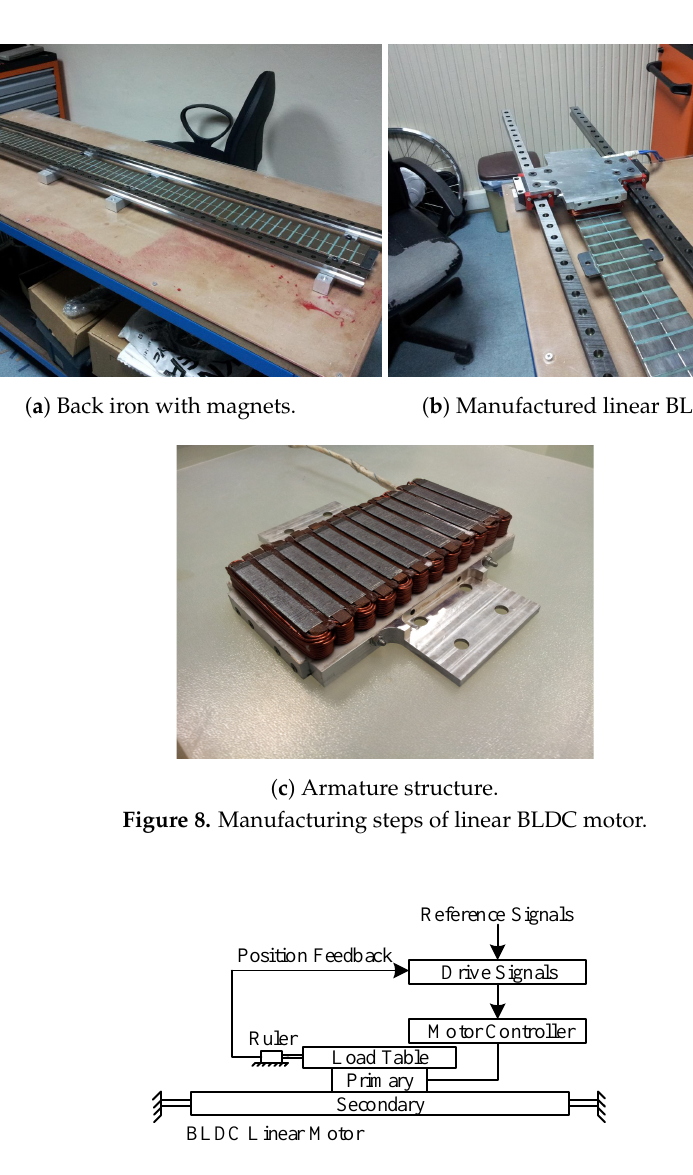
Figure 9. Experimental test bed block schema.